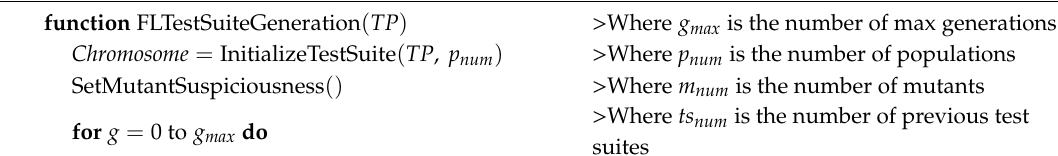
Algorithm 4. Fault-localizing test-suite